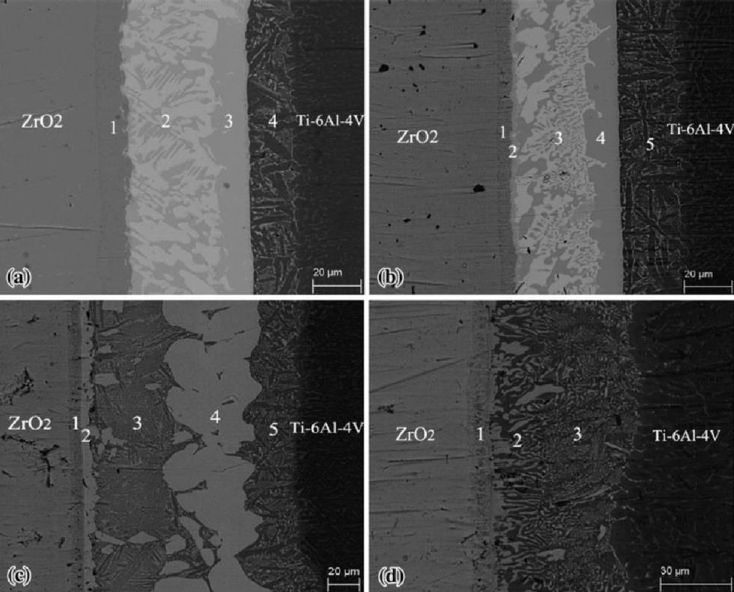
Figure 10. Microstructures of the joints after brazing at different temperatures for 5 min with a cooling rate of 5 K/min: ( a ) 900 °C; ( b ) 925 °C; ( c ) 950 °C; ( d ) 1000 °C, reproduced from Reference [33] with permission of Springer, 2013. Metals 2018 , 8 , x FOR PEER REVIEW